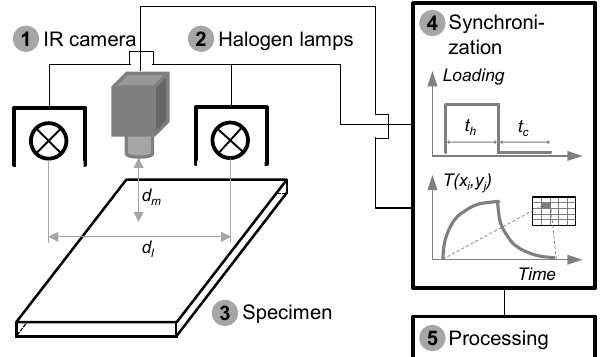
Figure 1. Test field for infrared inspection.